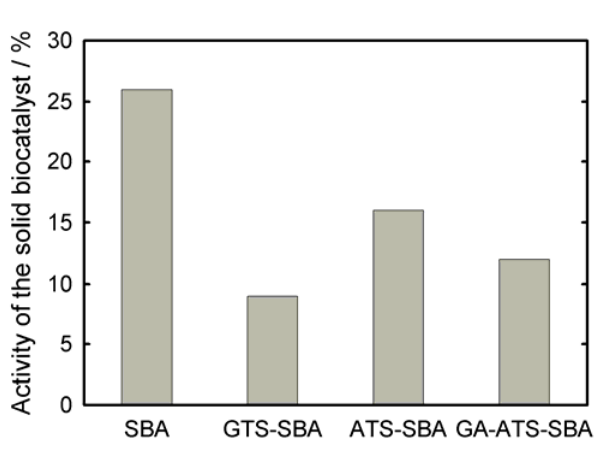
Figure 7. Activity of the covalent immobilized glucose oxidase on SBA-15 and modified materials expressed in percent of the initial solution activity (pH = 4.0), determined as described in the Experimental